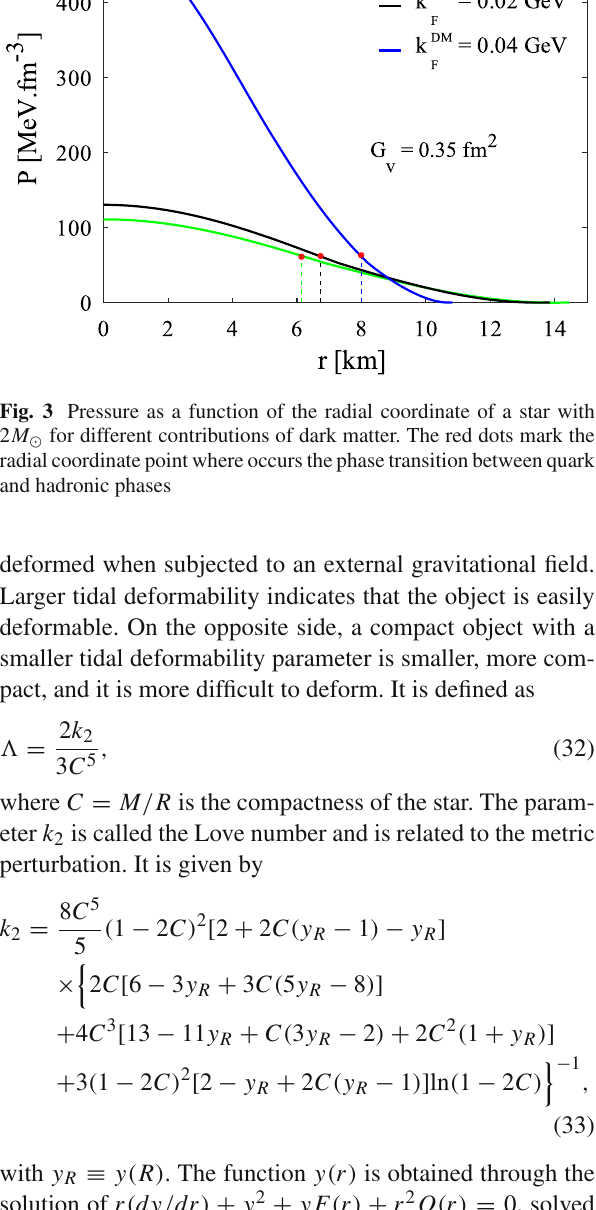
Table 2 Quark core size, r core , the maximum radii and the fraction, r core / R for different coupling constants of the vector MIT bag model, G V , and dark matter Fermi momentum, k DM Note that the dark matter contribution increases the core